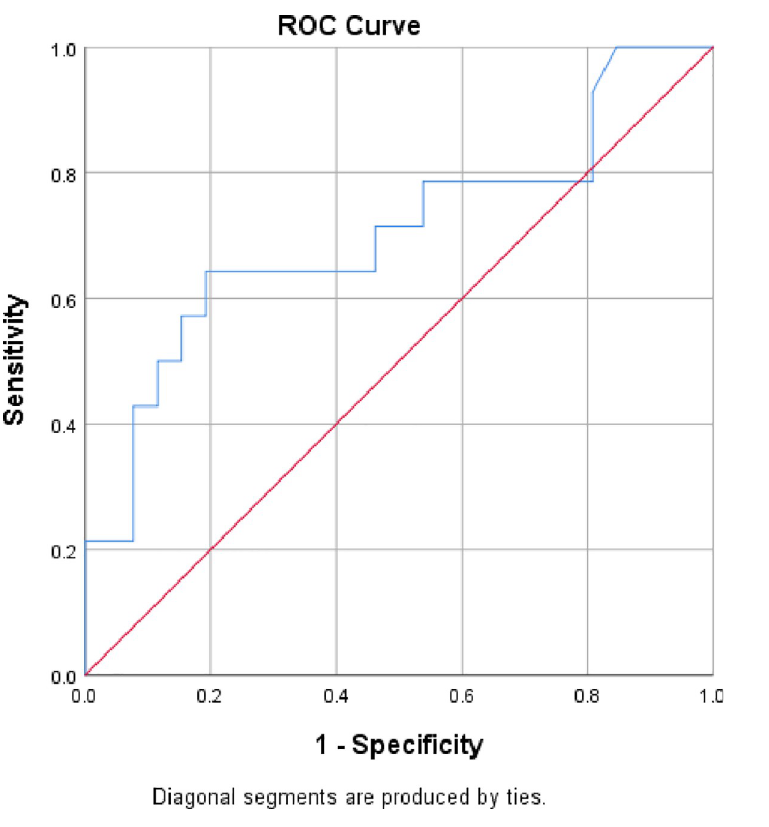
Fig 3. ROC curve for sensitivity and specificity of CBF for mortality.